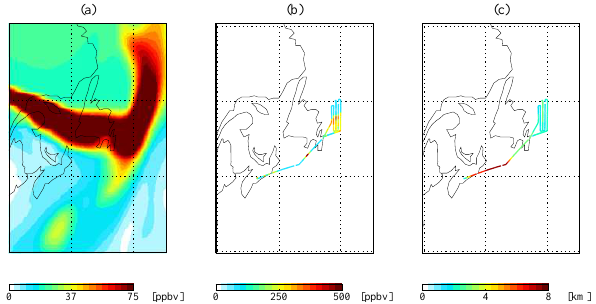
Fig. 7. (a) GEOS-5 model CO concentration (ppb) forecast for 1930Z at 750hPa (initialized at 00Z on the same day), (b) BAe- 146 aircraft CO measurements (ppb) and (c) altitude (km) for flight B624, 21 July